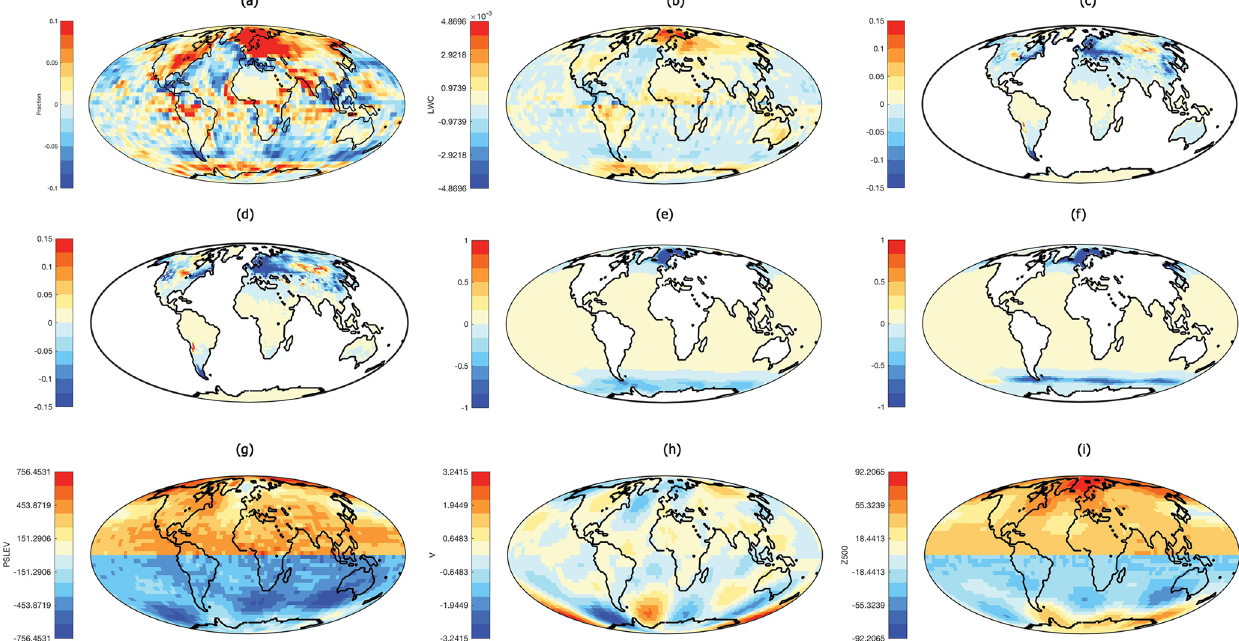
Figure 8. The effect of interhemispheric continental distribution on (a) mean annual cloud cover fraction, (b) liquid water content from all cloud types (kgkg − 1 ), (c) fractional snow cover (annual mean), (d) fractional snow cover (averaged over spring months), (e) fractional sea- ice cover (annual mean), (f) fractional sea-ice cover (averaged over spring months), (g) sea level pressure (Pa, annual mean), (h) northward wind (ms − 1 , annual mean) and (i) 500hPa geopotential height (m, annual